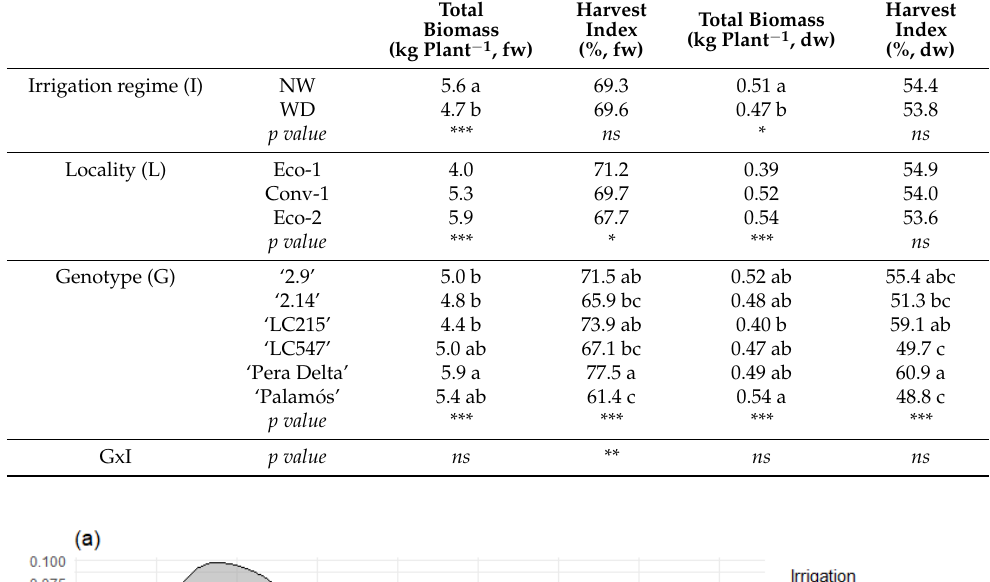
Table 3. Effect of irrigation regime (I), genotype (G) and locality (L) on biomass partitioning (expressed in fresh (fw) and dry (dw) weight). The level of significance is reported following * p < 0.05; ** p < 0.01; *** p < 0.001; ns, not significant ( p > 0.05). Within columns and for each fixed factor (I, G) different letters indicate significant differences according to Tukey multiple-range test ( p < 0.05). NW, normal watering; WD, water deficit. Genotypes: 2.9 and 2.14, Penjar breeding lines; LC215 (Penjar) and LC547 (Ramellet), LSL traditional lines; Palam ó s, Penjar modern hybrid; Pera Delta, processing variety. Total Biomass